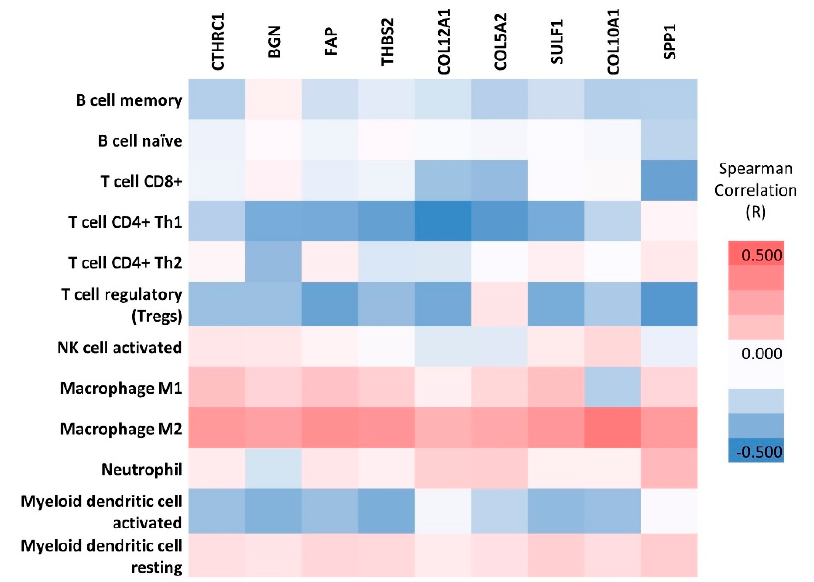
Figure 6. Analysis of tumor infiltrate in GC. Correlation between hub genes and 12 immune cell types in tumor microenvironment based on Spearman’s rho.